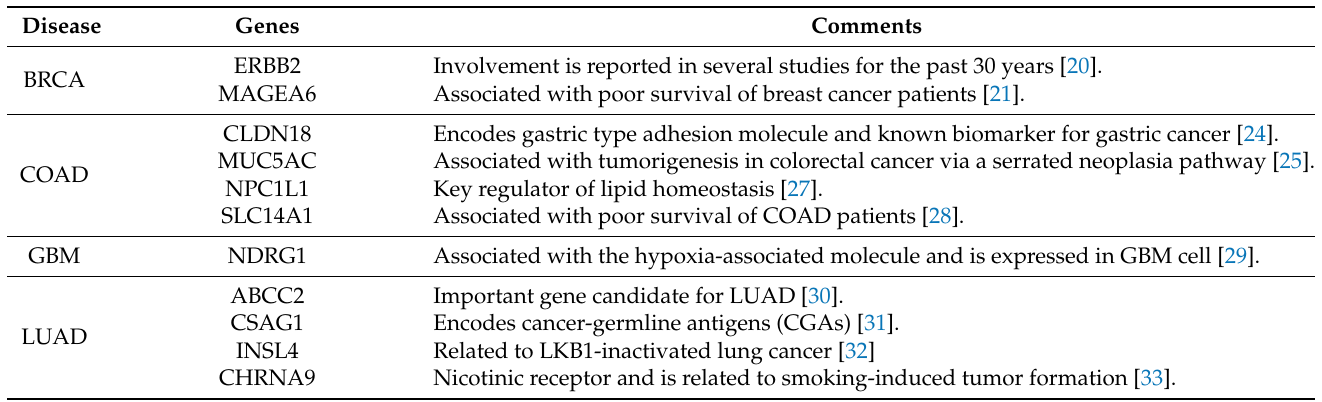
Table 2. List of previously validated genes selected by our